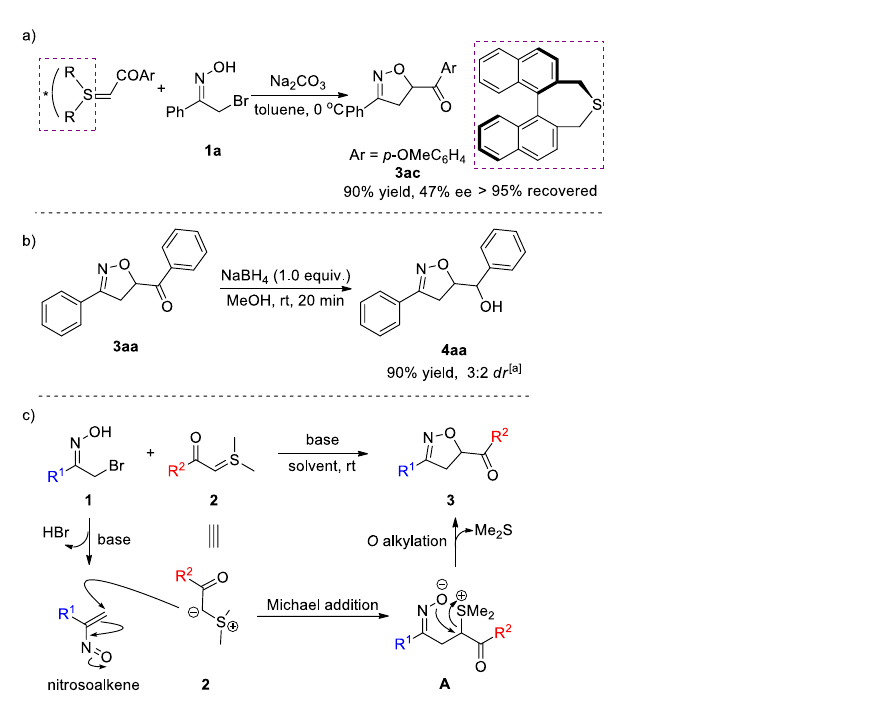
Figure 4. ( a ) Asymmetric reaction using ( R )-BINOL derived chiral sulfur ylide; ( b ) Synthetic transformation of product 3aa ; ([ a ]: The diastereomeric ratio was determined via 1 H NMR analysis of the crude reaction mixture.) ( c ) proposed mechanism for the [4 + 1] annulation